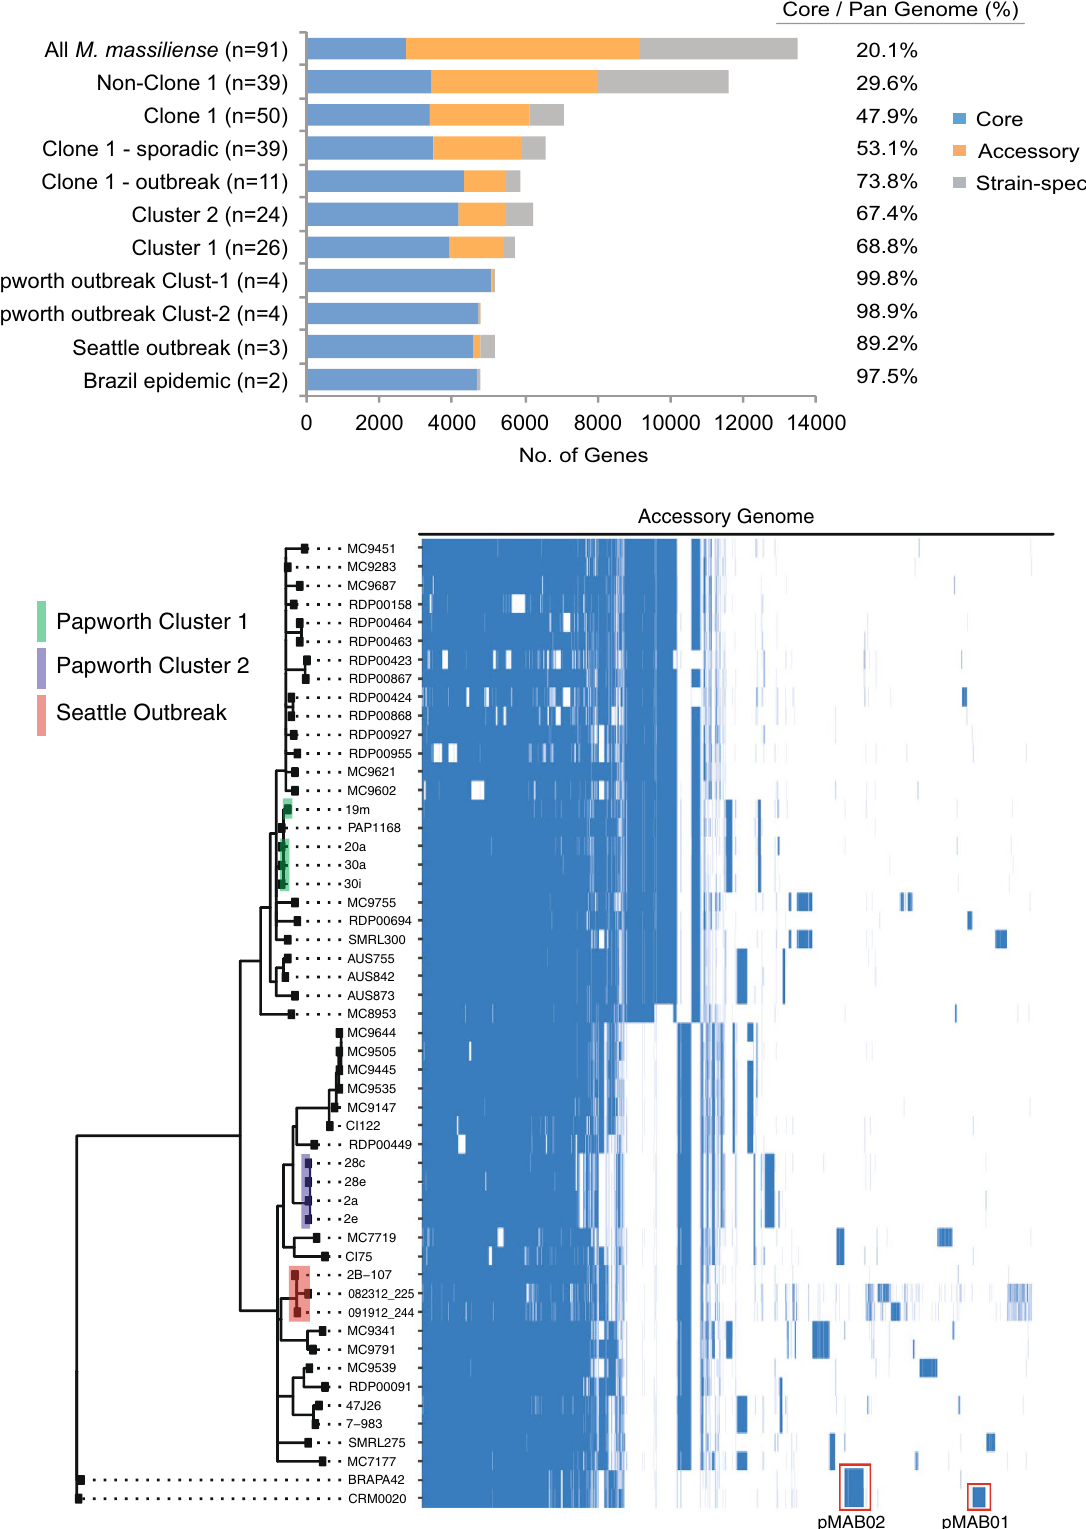
Figure 3. Pan genome of M. massiliense . Pan genome analyses were performed for M. massiliense isolates that passed genome assembly quality filters (see “Methods”; n = 91). ( A ) Pan genome results for all isolates in the dataset and various isolate subgroups are shown as numbers of core genes, accessory genes and strain-specific genes. Percent of core genes for each group is shown (core genes/ total genes in pan genome). ( B ) Visualization of the accessory genome for Clone 1 M. massiliense isolates. Accessory genes for Clone 1 isolates (n = 50) and Brazilian epidemic isolates (n = 2) are shown as a presence or absence heatmap (blue means presence of a gene). Samples are ordered based on the core genome phylogenetic tree (left side). Known outbreak isolate clades are color coded for reference, and plasmids are indicated with red